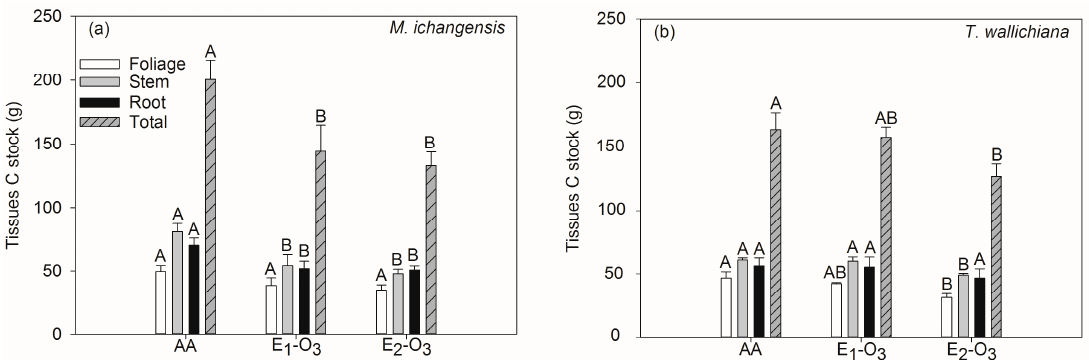
Figure 2. Effects of elevated O 3 on individual tissues C stock of M. ichangensis ( a ) and T. wallichiana ( b ). Bars indicate standard error of the mean ( n = 3). Different capital letters indicate a significant difference between O 3 fumigation treatments for the same tree tissues ( p < 0.05).